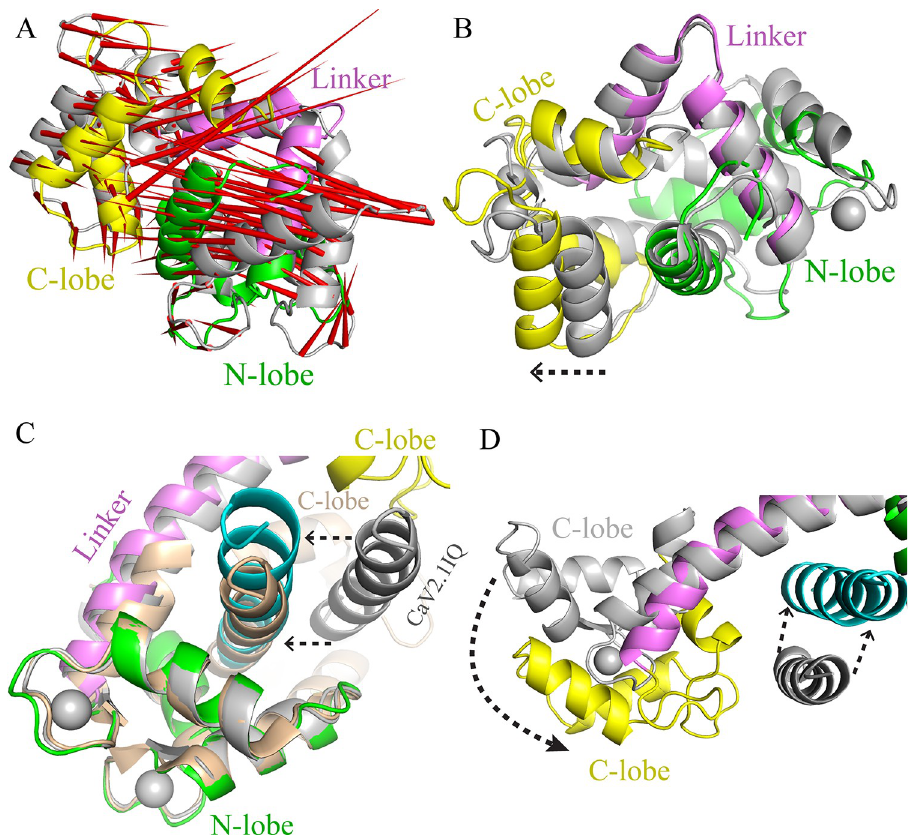
Fig 6. (A) Compact Ca 2+ / CaM is dynamic in solution. Both lobes and the linker are deviate from their initial positions. (B) The lobes move apart slightly and widens the compact Ca 2+ /CaM. (C) In an artificial complex of CaM and IQ motif (grey), IQ peptide moves towards and binds CaM in its natural binding position. Final simulated structure is show in multicolour (N-lobe; green, C-lobe; yellow, and linker; violet). Ca 2+ /CaM-Cav2.1IQ (3DVM) is shown in wheat colour. (D) Following peptide binding to CaM, the central linker bends. The movement of peptide and bending of the linker is shown by dotted